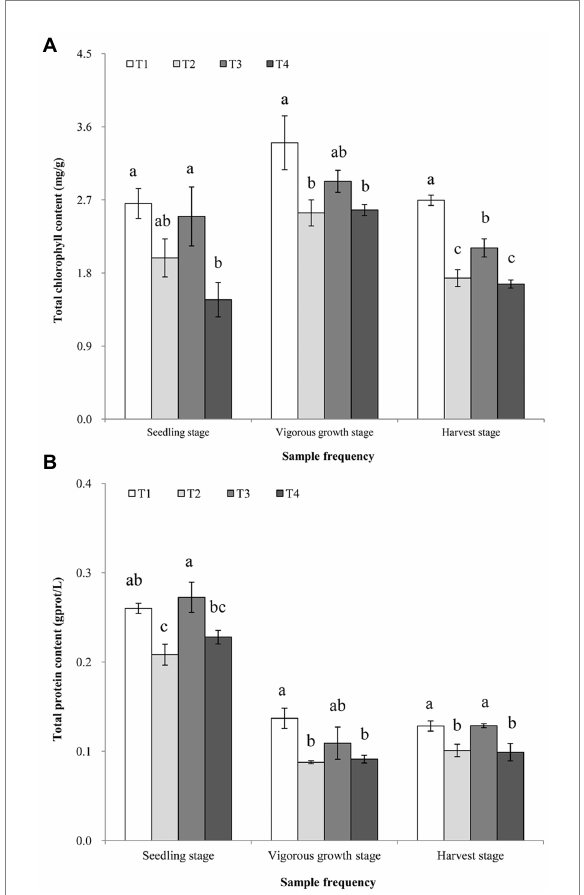
FIGURE 2 Analyzes of total chlorophyll (A) , and total protein (B) , contents in the ginger plants harvested at the three stages. T1, soil treated with R. palustris PSB-06 and dazomet; T2, soil treated with dazomet alone; T3, soil treated with R. palustris PSB-06 alone; T4, soil without treatment (blank control). Same low case letters indicate no significant statistical difference ( p > 0.05) between the treatments, determined using the Duncan’s multiple range